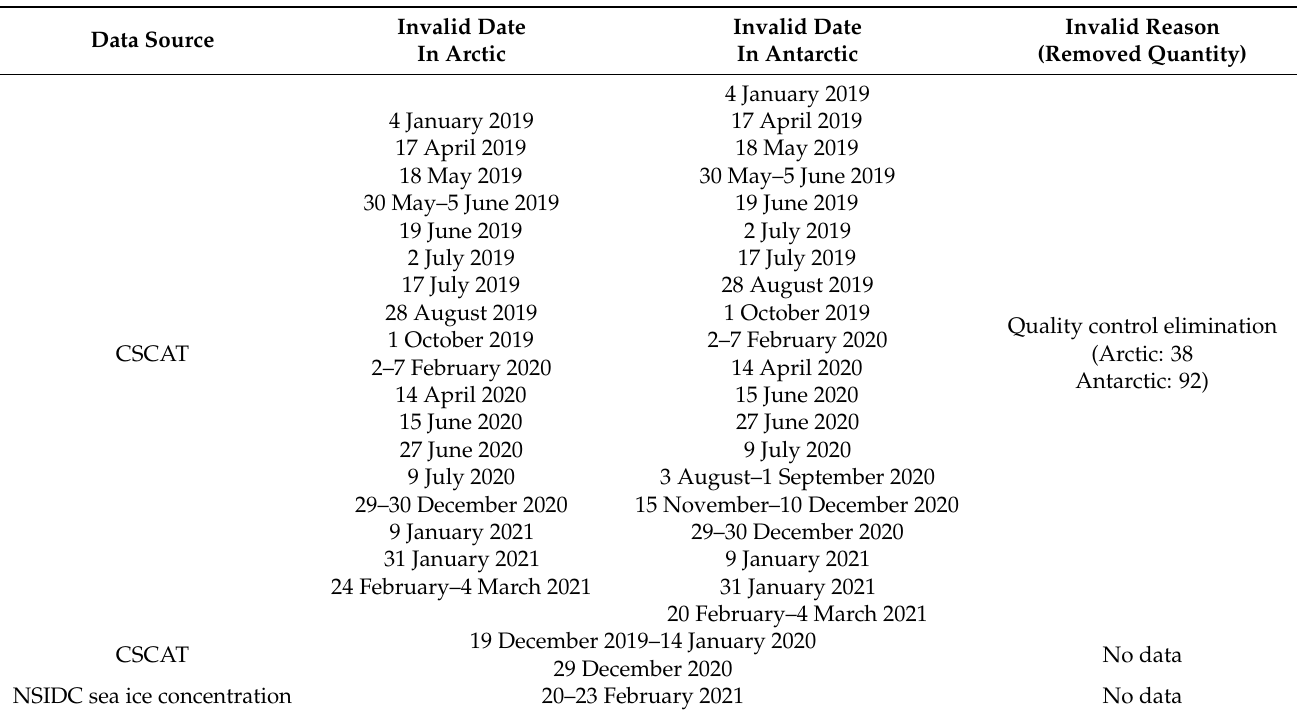
Table 5. The list of invalid dates and reason for statistical analysis from 1 January 2019 to 10 May